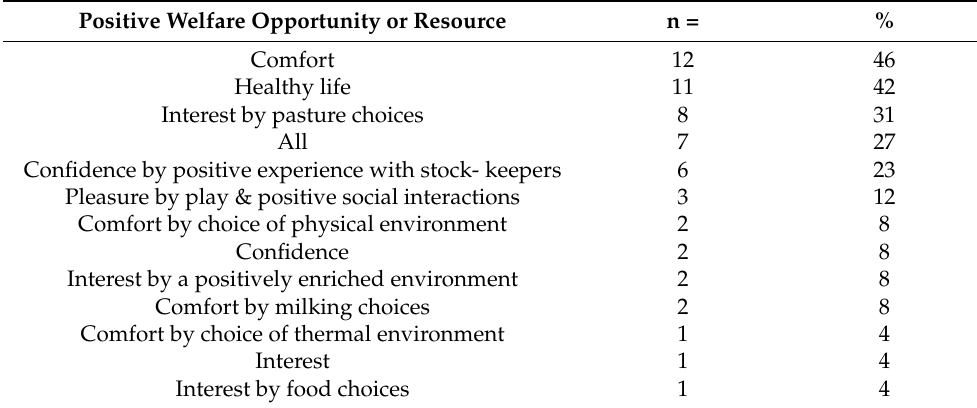
Table 2. Positive welfare opportunity or resources most valued by farmers (n = 27).